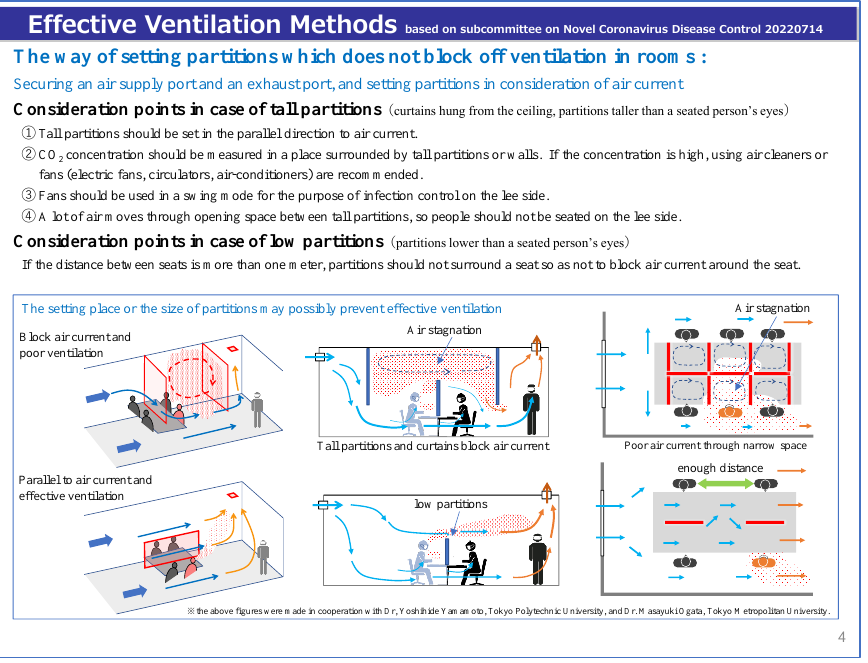
Figure 11. The way of setting partitions which does not block off ventilation.